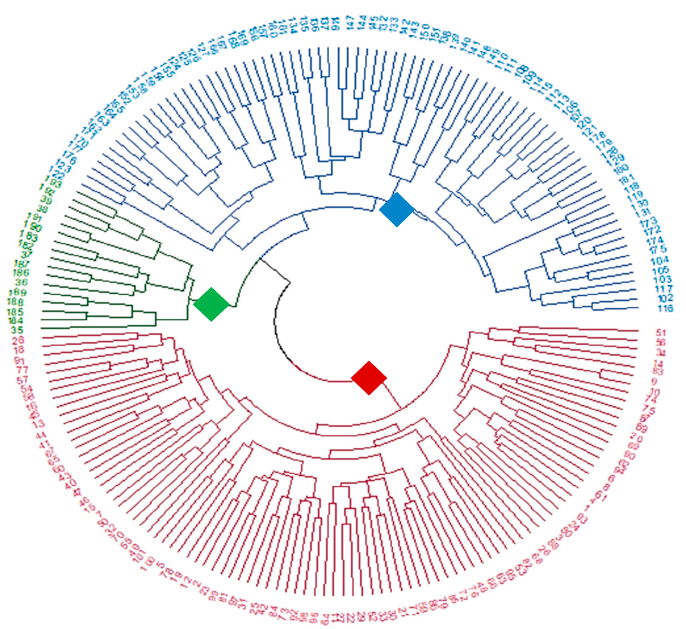
Figure 6. Discriminant analysis of principal components (DAPC) among nine natural populations of A. marina across the Farasan archipelago. Eigenvalues are presented here.